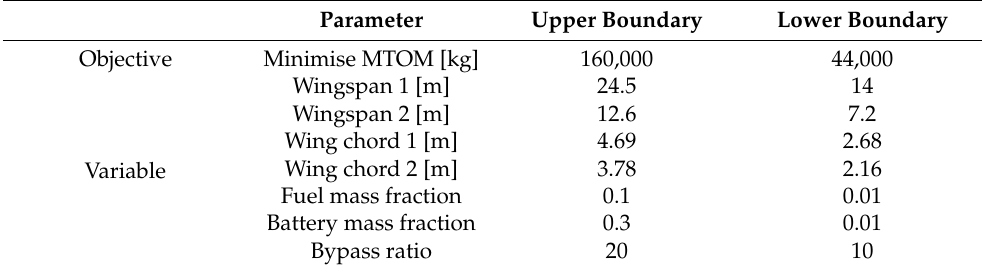
Figure 3. Overview of two-step optimisation framework for exploring the balancing of the hybrid- electric aircraft design. Table 2. Objective and design variables for optimisations in Step A.